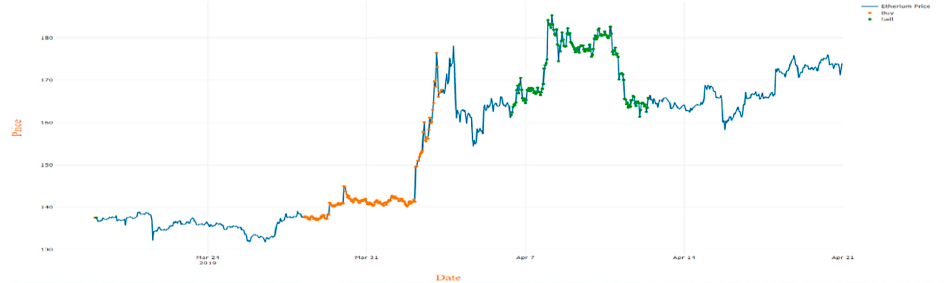
Figure 11. Experiment results on Ethereum. Yellow point present purchases, green point present “sell”.